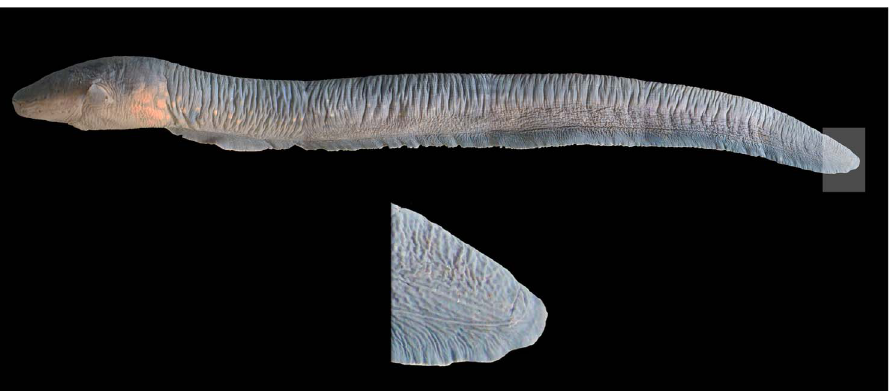
Figure 1. Lateral view of Electrophoruselectricus, MPEG 25422, 1000 mm TL. Continuous compound fin along ventral surface of body and posteroventral portion of tail shown in upper figure and close up of compound anal-caudal fin at tip of tail in lower